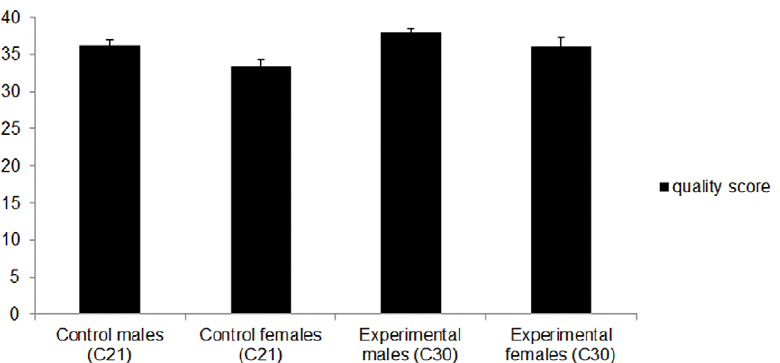
Figure 4. Mean ± SEM quality scores of C21 and C30 hatchlings (C21 male chicks: N=21; C21 female chicks: N=26; C30 male chicks: N=27; C30 female chicks: N=21).